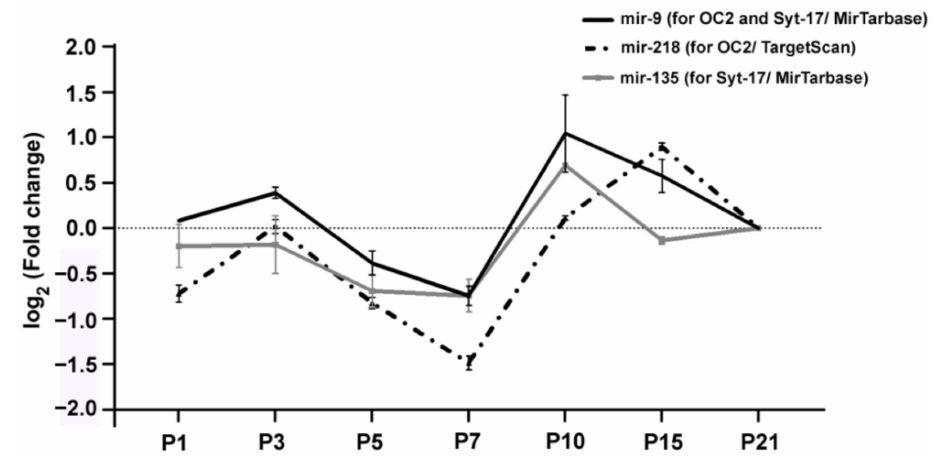
Figure 1. The sequencing results of mir-9 (black line), mir-218 (dashed line) and mir-135 (gray line). Fold changes are represented as log2 fold change compared with P21. OC2, OneCut2; Syt-17,